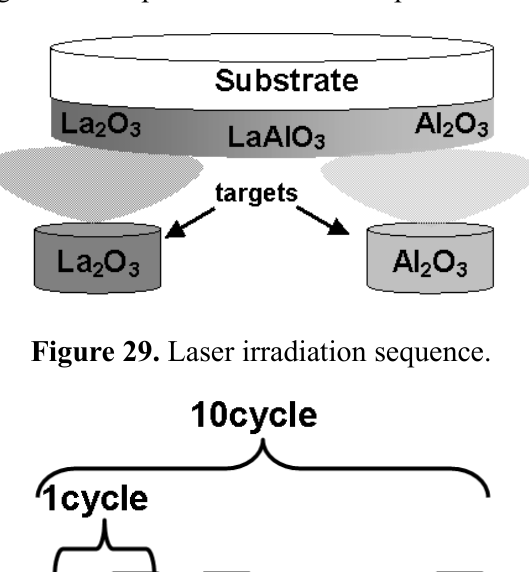
Figure 28. Schematic diagram of the positional relationships between the targets and substrate.